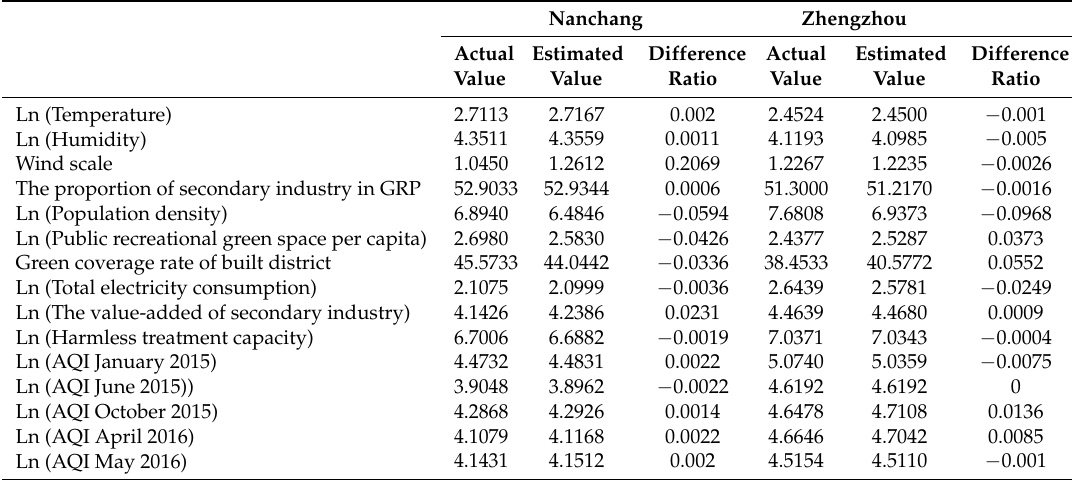
Table 5. The actual value and the estimated value of predictive